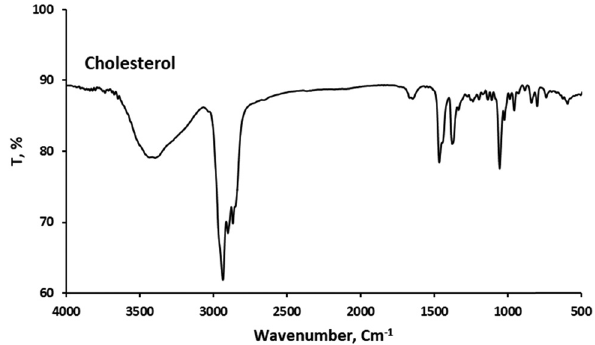
Figure 2: Fourier transform infrared spectra of cholesterol ( Chol ) .